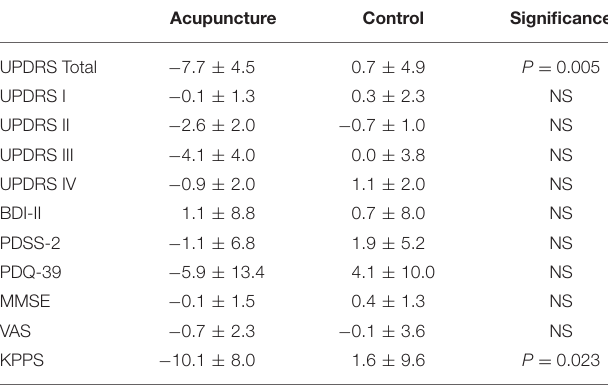
TABLE 2 | Changes of clinical features between baseline and